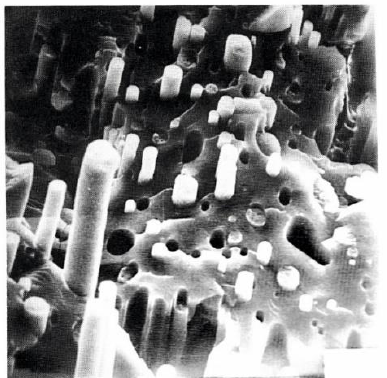
Figure 26. Cross section of the extrudate containing two incompatible polymers. Analytical SEM pictures combined with spectroscopy on Auger electrons give a rather expressive structure organization in the extrusion of a two-component blend of polysulfone (PSF; sulfur atoms are marked by green), and LC polyester (LCP; oxygen atoms are marked by red) (Figure 27) [130]). One can see a quite random distribution of the components after mixing (left) and their layered distribution as a result of the shear flow (right). The low-viscous LC component forms longitudinally elongated fragments in the isotropic matrix. In addition, LCP forms a thin surface layer that can be a result of being pressed out of the low viscous LCP on the conical section at the entrance to a capillary. Interestingly, the viscosity of a blend is rather close to the viscosity of the LC phase, which is much lower than the viscosity of the thermoplastic polymer [130].